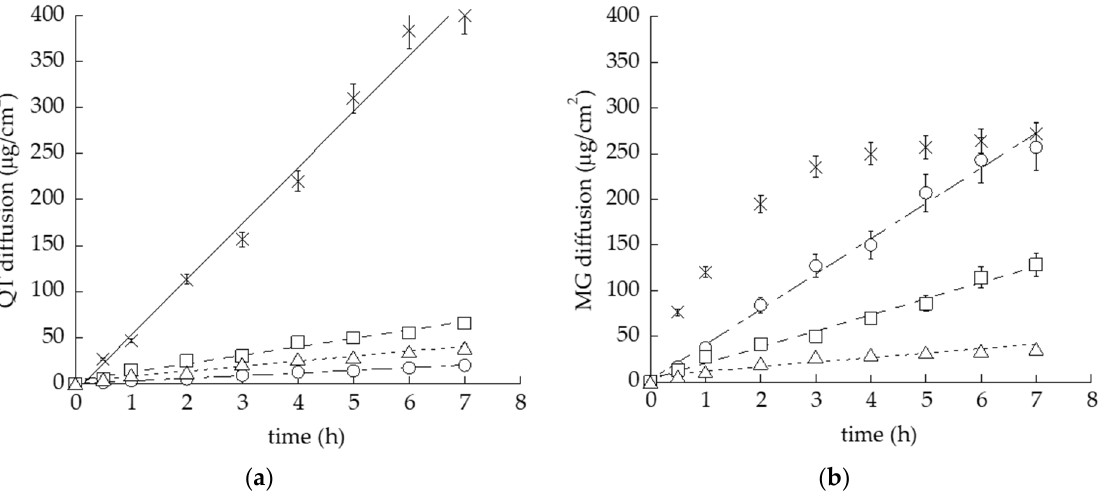
Figure 4. In vitro diffusion kinetics of QT ( a ) and MG ( b ) loaded in OG (circles), POL (squares), POG (triangles) or solubilized in ethanol/water, 30:70 v/v (crosses), as determined by Franz cells associated with PTFE membranes.